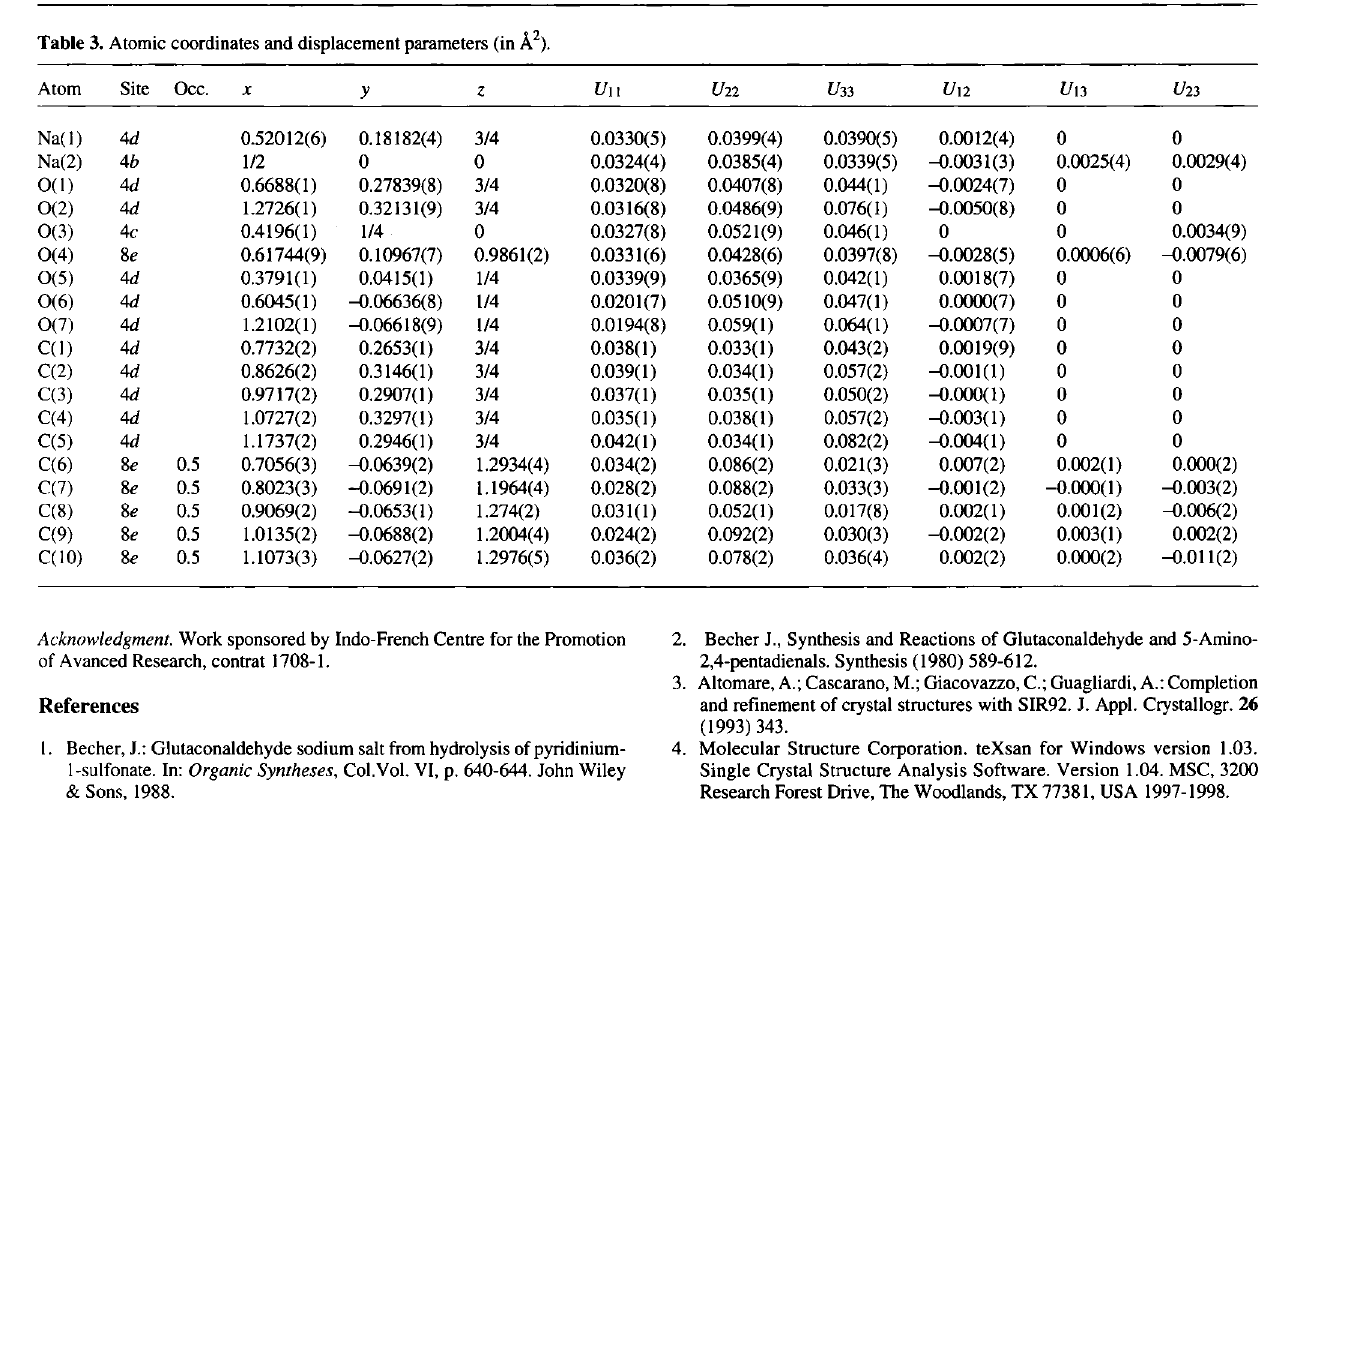
Table 3. Atomic coordinates and displacement parameters (in Ä 2 ). Atom Site